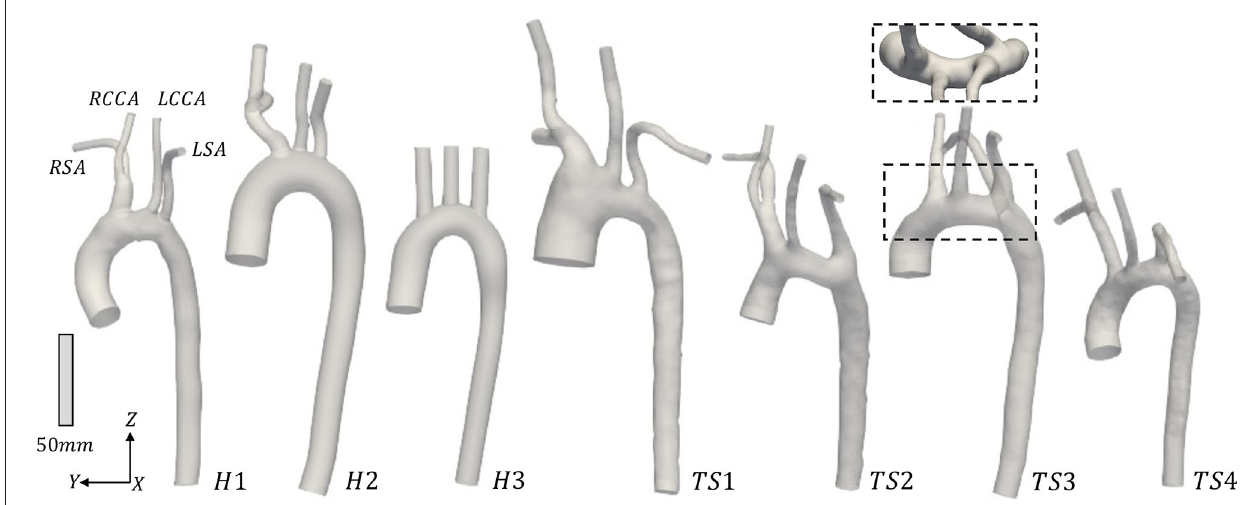
FIGURE 1 | Anterior view of the reconstructed aortic models from the (H1-H3) healthy and (TS1-TS4) Turner syndrome (TS) girls. RSA, Right subclavian artery; RCCA, right common carotid artery; LCCA, left common carotid artery; LSA, left subclavian artery. Inset: Superior view of TS3 to highlight the origin of the aberrant RSA. Geometries are in scale.